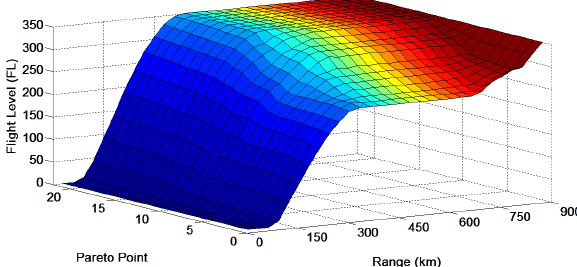
Fig. 3: Altitude profiles for Pareto set.